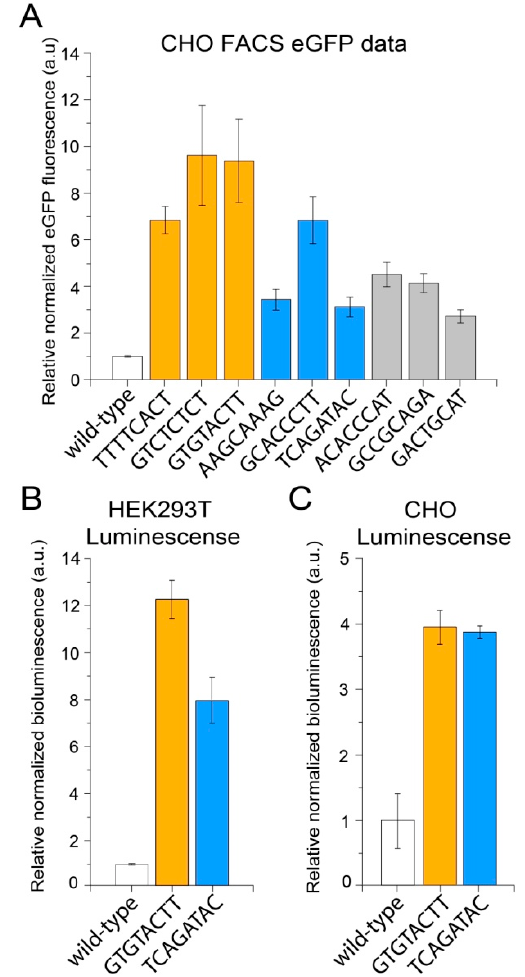
Figure 7. The positive effects of GTGTACTT and TCAGATAC mutations on the expression levels of different upstream reporter genes and in different cell lines. ( A ) Flow cytometry analysis of the eGFP protein expression in CHO cells transiently transfected with the plasmids bearing the indicated individual mutations. ( B , C ) The luciferase protein activity in HEK293T ( B ) and CHO ( C ) cells transiently transfected with the plasmids bearing the indicated individual mutations.